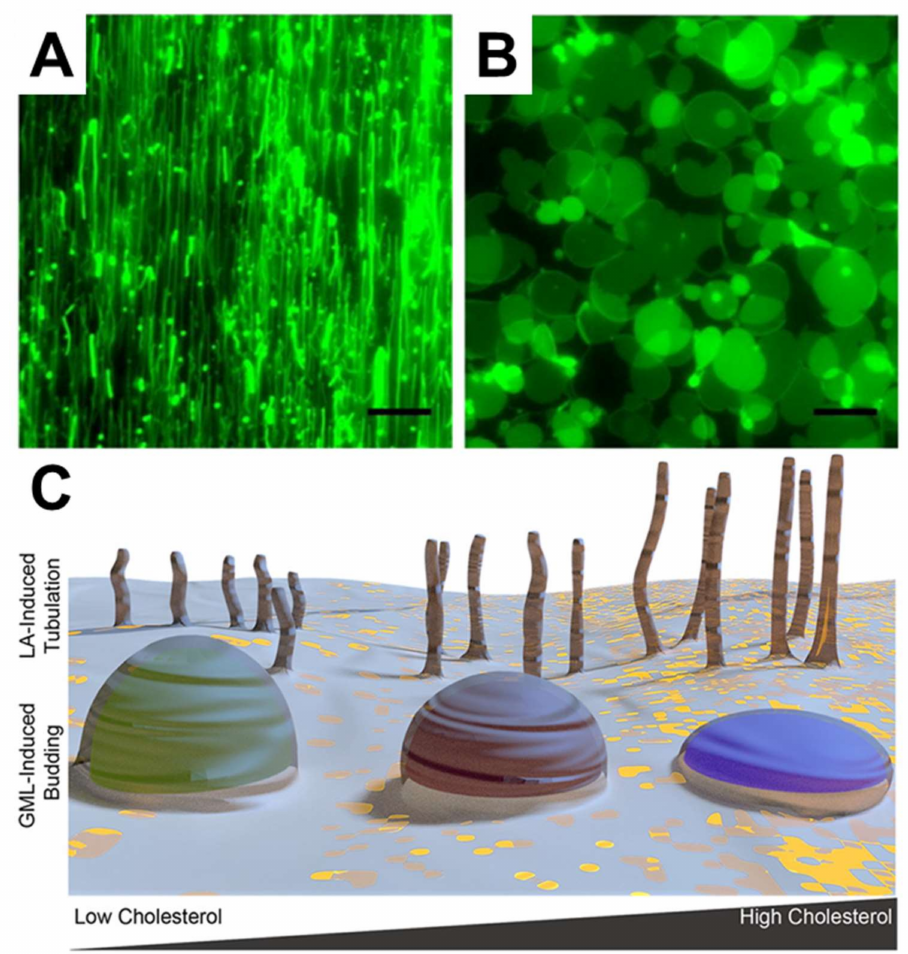
Figure 7. Membrane morphological responses induced by LA and GML. The morphological responses occurred after treating ( A ) 2 mM LA and ( B ) 500 µ M GML on DOPC SLBs. The scale bars are 20 µ m. ( C ) schematic representation of how membrane morphological responses are induced on cholesterol-rich SLBs with treatment of LA and GML. Reproduced with permission from [109] (Copyright 2015, American Chemical Society) and [133] (Copyright 2017, American Chemical